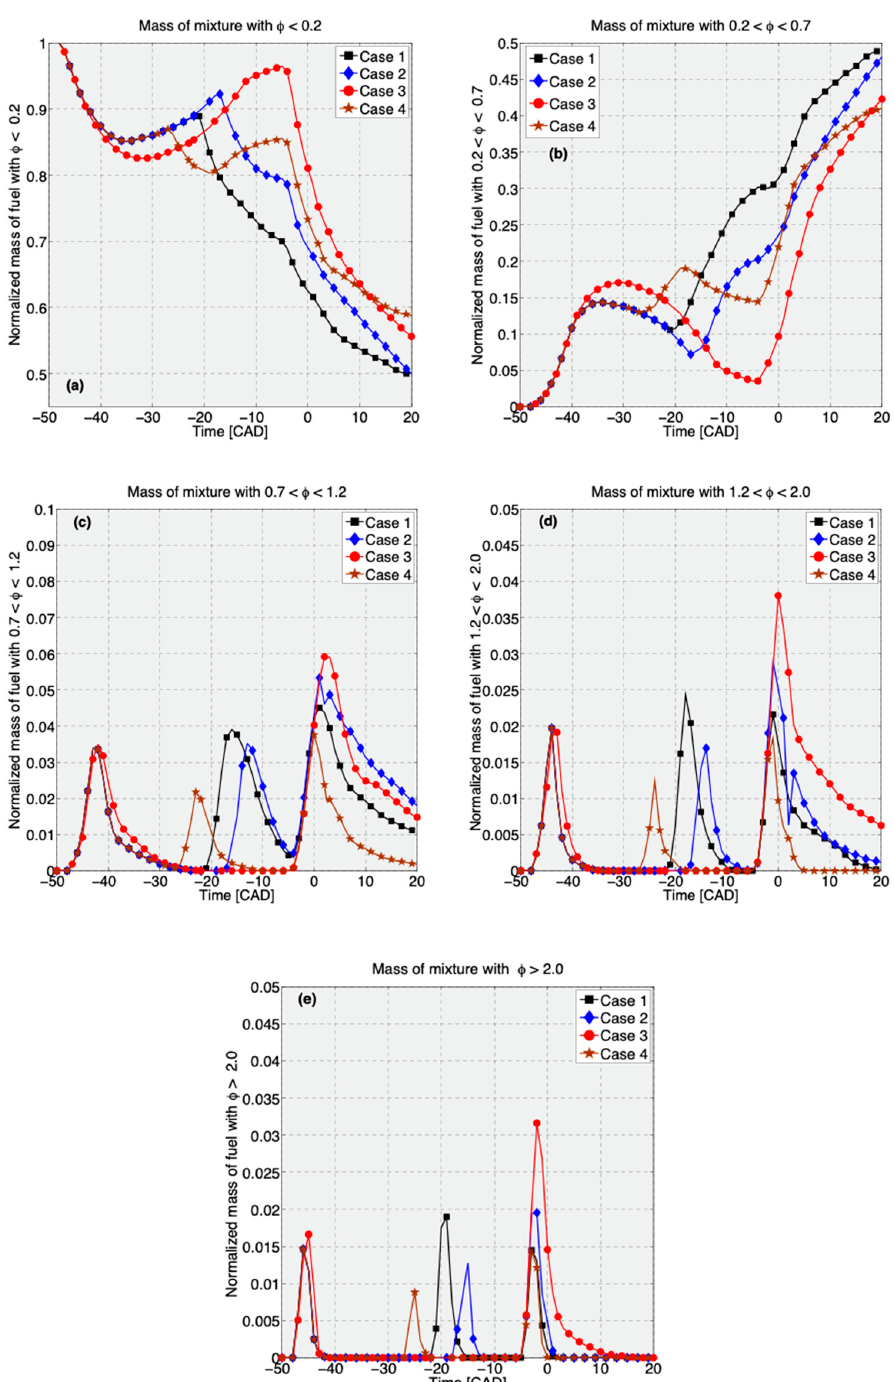
Figure 11. Normalized mass of fuel from the mixtures at various ranges of equivalence ratio. The fuel mass is normalized with the total fuel mass injected to the cylinder, i.e., 1.56 mg. The adjusted initial temperatures are case 2: 15 K; case 3: 30 K; case 4: 30 K. ( a ) φ < 0.2; ( b ) 0.2 < φ < 0.7; ( c ) 0.7 < φ < 1.2; ( d ) 1.2 < φ < 2; ( e ) φ > 2.